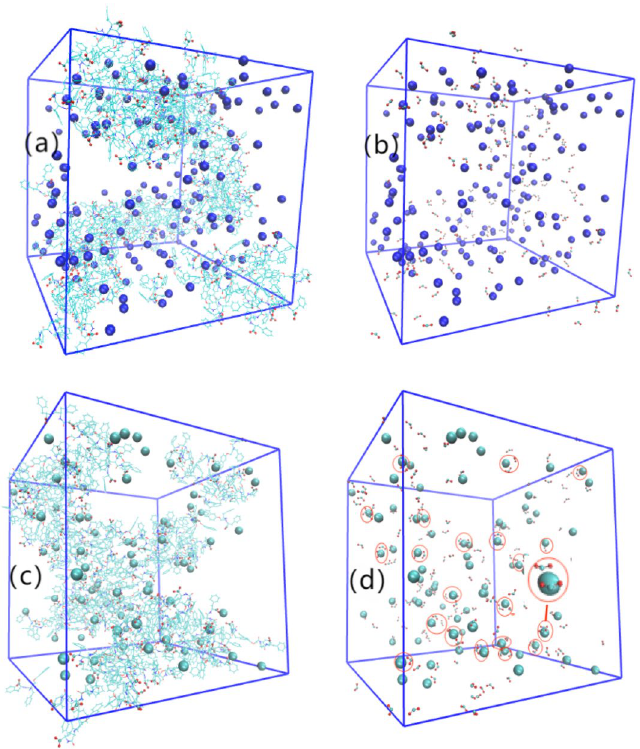
Figure 5. The images of the long worm-like micelle (7) and gel in system (8). ( a ): Only Na + and 2NapFF; ( b ) only Na + and carboxylate COO − ; ( c ) only Ca 2+ and 2NapFF; ( d ) only Ca 2+ and carboxylate COO − .